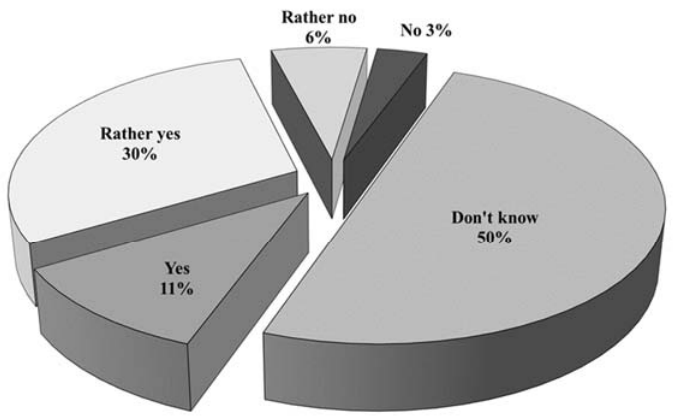
Figure 3. Answers to the question about the differences between power banks equipped with lithium-ion and lithium-polymer batteries.